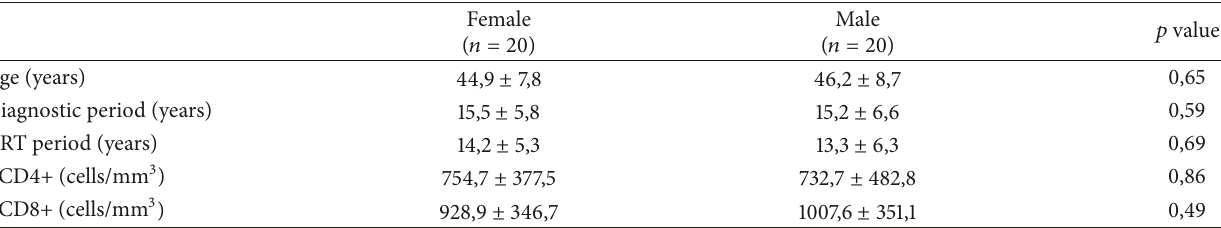
Table 3: Clinical-immunological people living with HIV/AIDS with clinical HIV-associated lipodystrophy syndrome diagnosis separated by